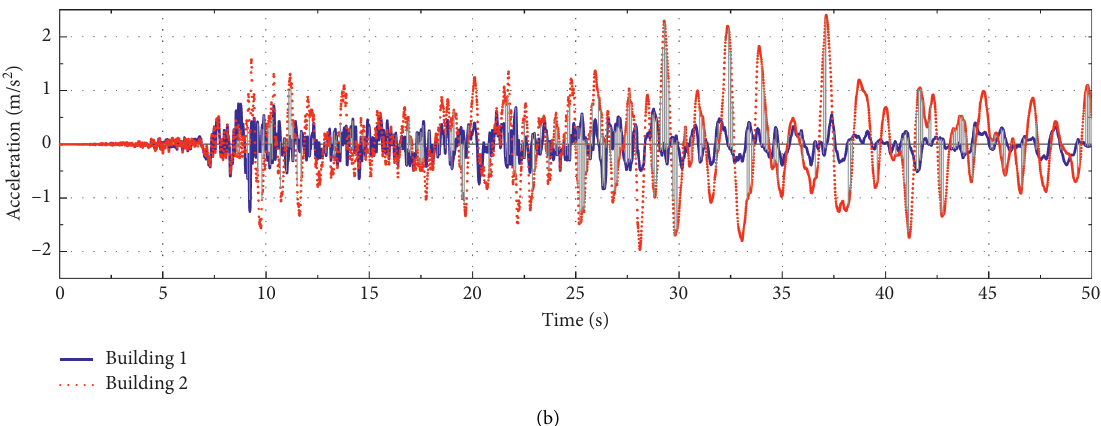
Figure 12: Time histories of acceleration responses at 210.2m height under (a) 90 ° wind direction and (b) the No. 10 earthquake excitation.